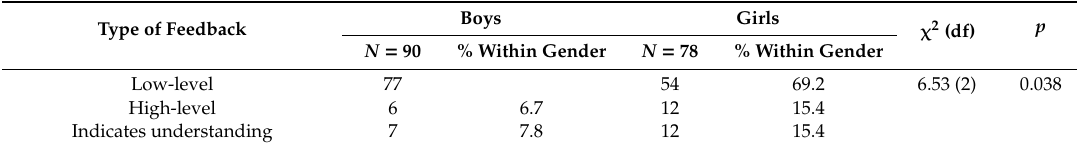
Table 6. Chi-square test of independence of gender and type of response from